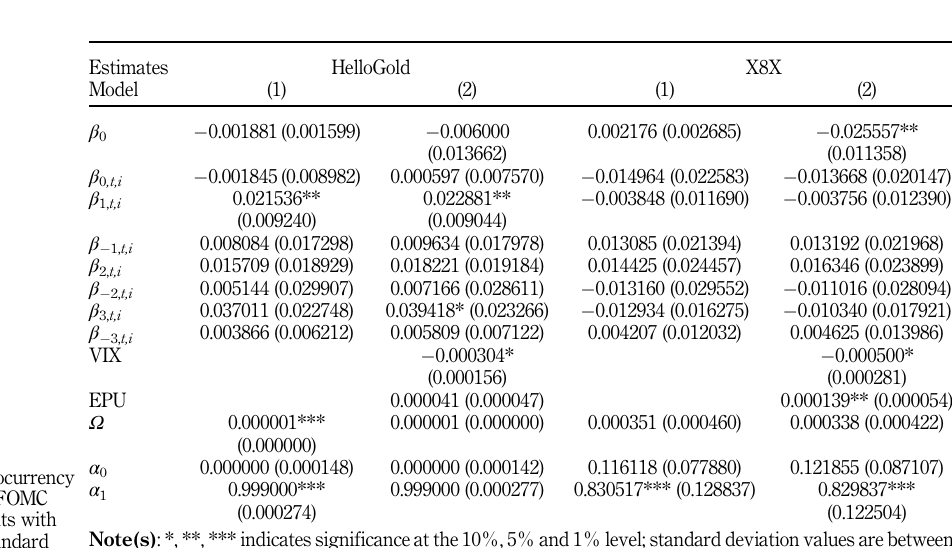
Table 1. Conventional cryptocurrency responses to FOMC announcements with the robust standard error regression